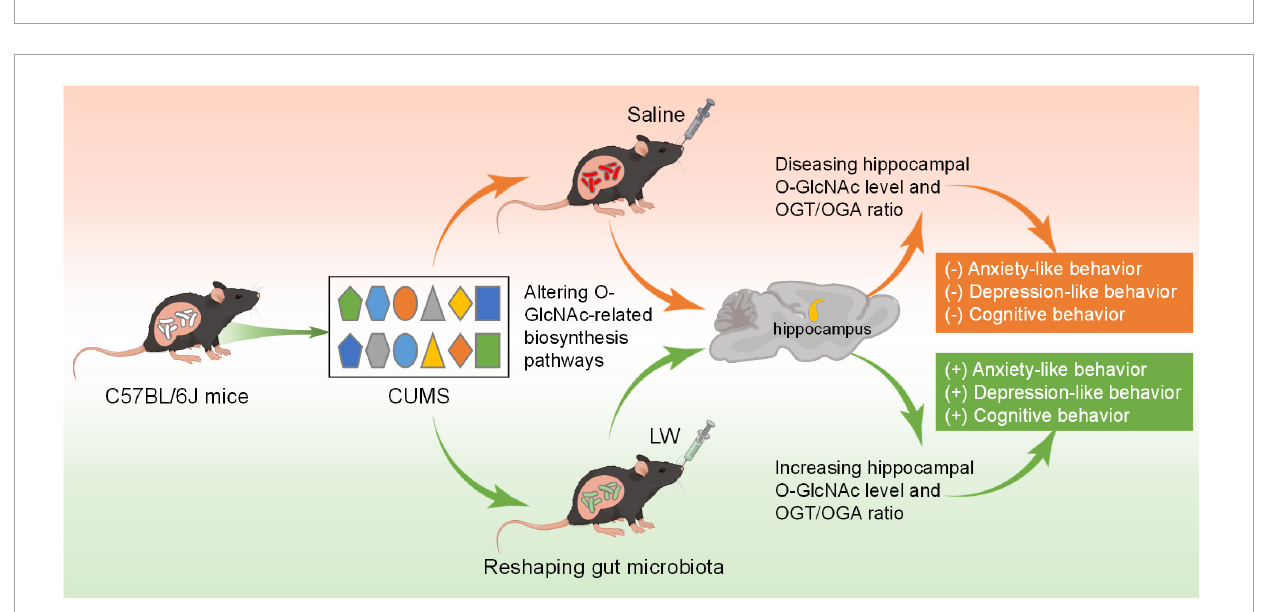
FIGURE8 Sketch map for the mechanisms of LW on CUMS induced emotional disorders and cognitive impairment. LW decreases the ratio of OGT/OGA levels in CUMS-14D mice but increases the hippocampal ratio of OGT/OGA in CUMS-28D mice. LW intervention increased the levels of hippocampal O-GlcNAc modification and ameliorated the emotional and cognitive impairments induced by chronic stress in CUMS mice.